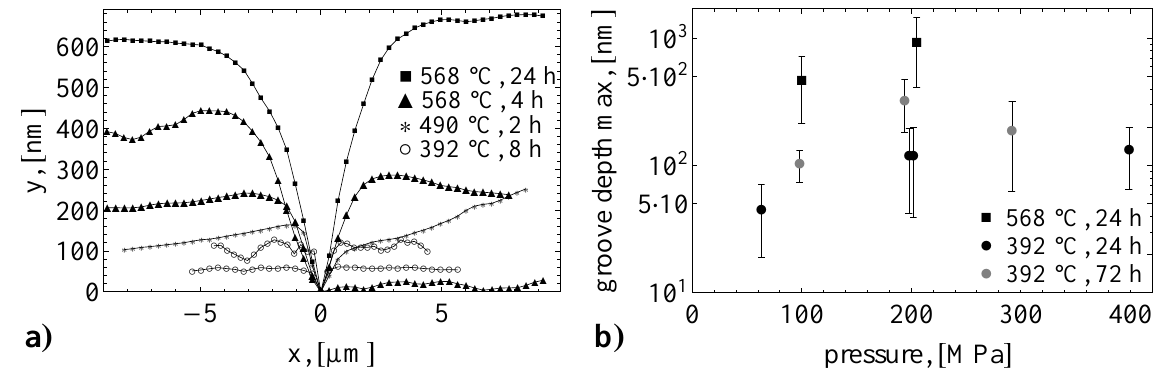
Figure 6. (a) Examples of observed groove geometries at a pressure ∼ 200MPa. (b) Groove depth, d max (average and standard deviation, see Table 2), as varying with pressure. Annealing conditions, temperature and duration are indicated by the labels.